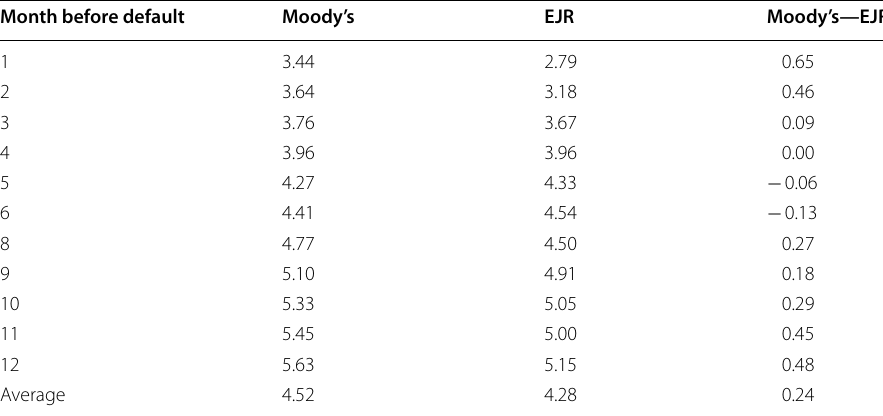
Table 5 Ratings given by Moody’s and EJR before defaults Month before